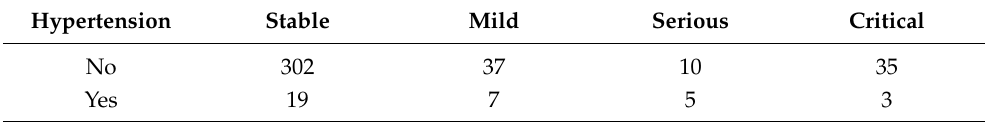
Table 4. Contingency table for exposure hypertension to Severity of the case.